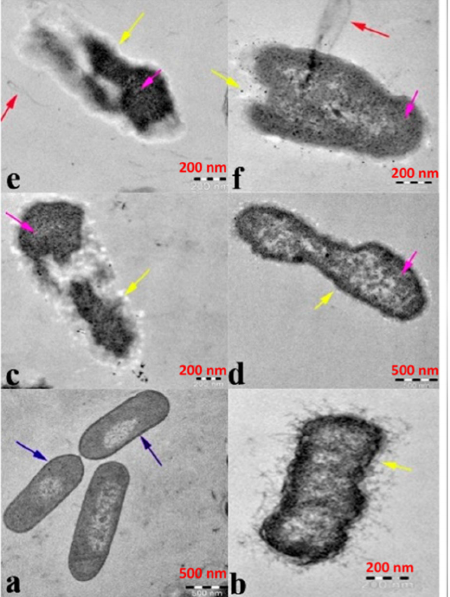
Figure 2. Image illustrating antibacterial efficacy against β‐ lactam ‐ resistant K. pneumoniae obtained using transmission electron microscopy: ( a ) ZnO − NPs in the untreated state and ZnO − NPs in the treated state ( b – e ). Cytoplasmic shrinkage ( b ) disrupted cell wall and membrane ( c ), denatured pro ‐ tein shows as a dark electron ‐ dense patch ( d ), and cytoplasmic spillage ( e , f ). The blue arrow repre ‐ sents an intact cell wall, the yellow arrow represents a disintegrating cell wall and cell membrane, and the violet arrow represents a denatured protein. (Reprinted from [30]; open access under CC BY).